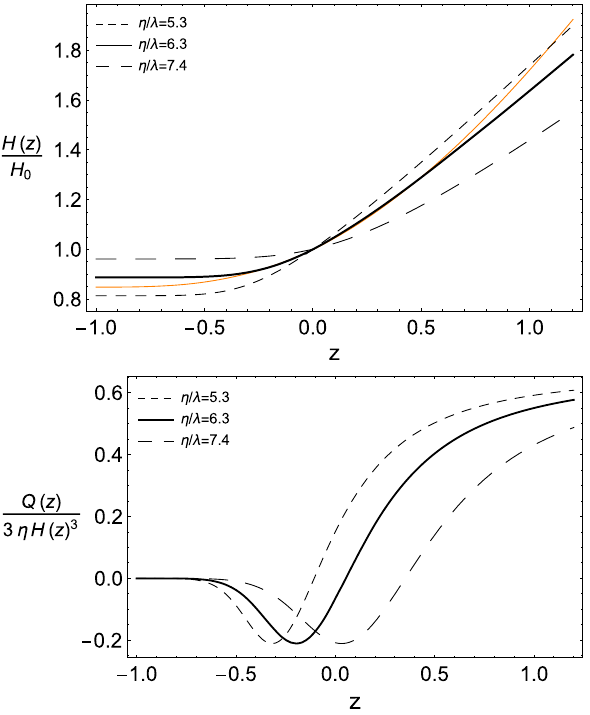
Fig. 1 For the GB DE model it is shown the evolution of the Hubble parameter H ( z ) (upper graph) and the coupling Q ( z ) (lower graph) as functions of the redshift z for the fixed value w = − 1 and several different values of the parameters η and λ . From Eq. (11), for η/λ = { 5 . 3 , 6 . 3 , 7 . 4 } we obtain q ( 0 ) ≈ {− 0 . 40 , − 0 . 55 , − 0 . 80 } . The orange line corresponds to the evolution of the Λ CDM